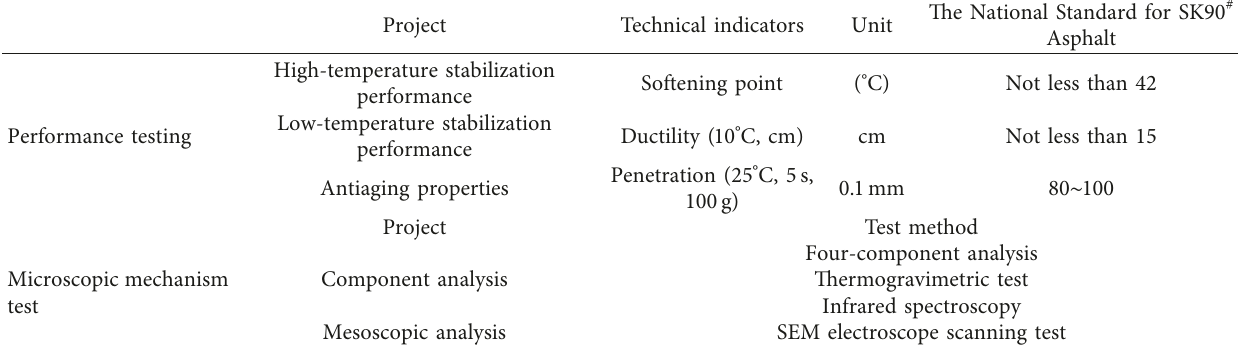
Table 1: Experimental scheme of gilsonite and SK90 # asphalt.